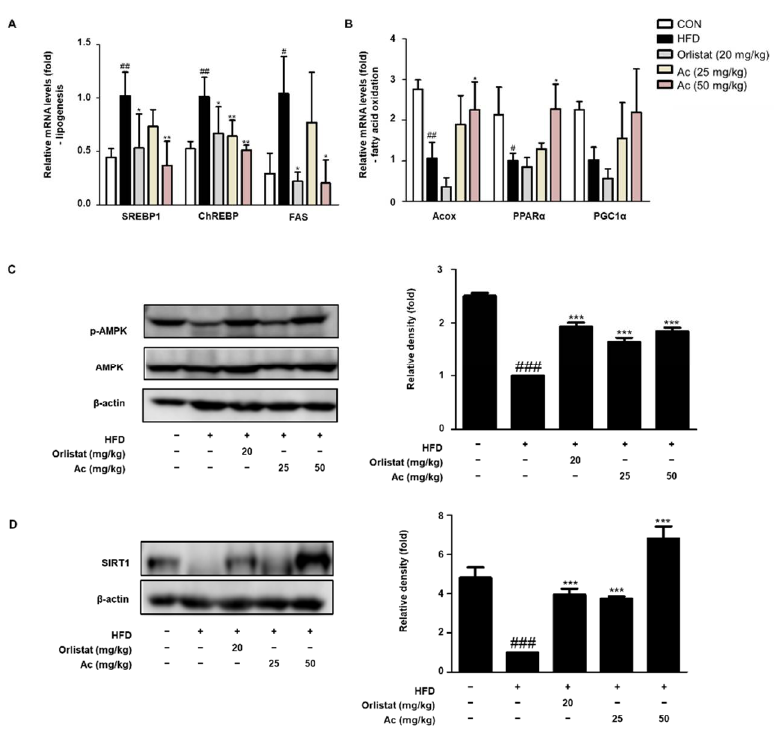
Figure 4. Effect of Ac on the lipogenesis and fatty acid oxidation markers in eWAT tissue of HFD- induced obese mice. The mRNA levels of ( A ) SREBP1, ChREBP, FAS, ( B ) Acox, PPARα, and PGC1α in eWAT assessed by qRT-PCR. The protein levels of ( C ) p-AMPK, AMPK, and ( D ) SIRT1 analyzed by western blot analysis. Densitometric analysis was performed using ImageJ v1.50i. Data are expressed as the mean ± SD of three independent experiments. # p < 0.05, ## p < 0.01, and ### p < 0.001 vs. chow diet-fed group; * p < 0.05, ** p < 0.01, and *** p < 0.001 vs. only HFD-fed group.